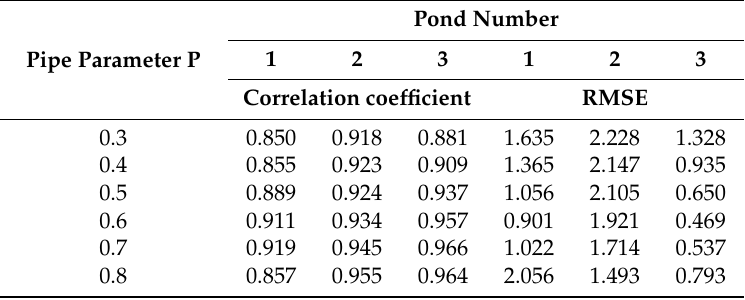
Table 6. The result of correlation coefficients and RMSE between simulated and observed groundwater levels according to pipe parameter of the Dalsung copper